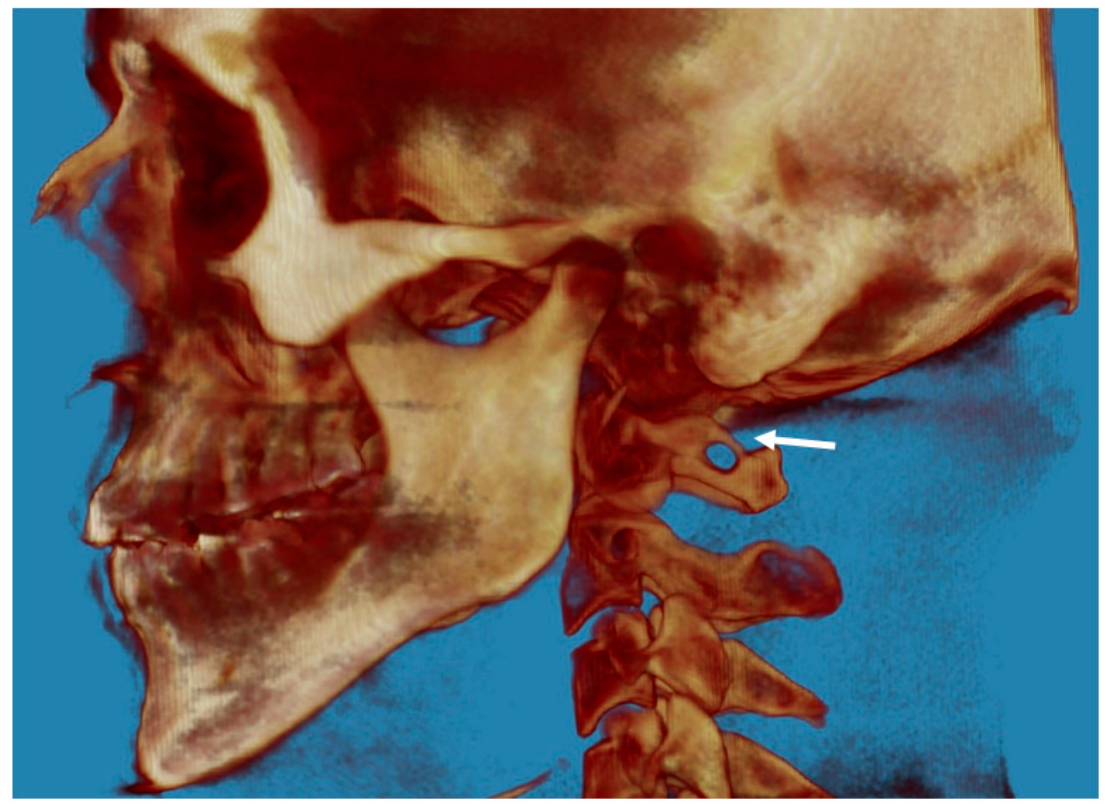
Figure 3. CBCT image of the complete PP on the left (indicated by the arrow). The image is taken from the “G. D’Annunzio” University archives.